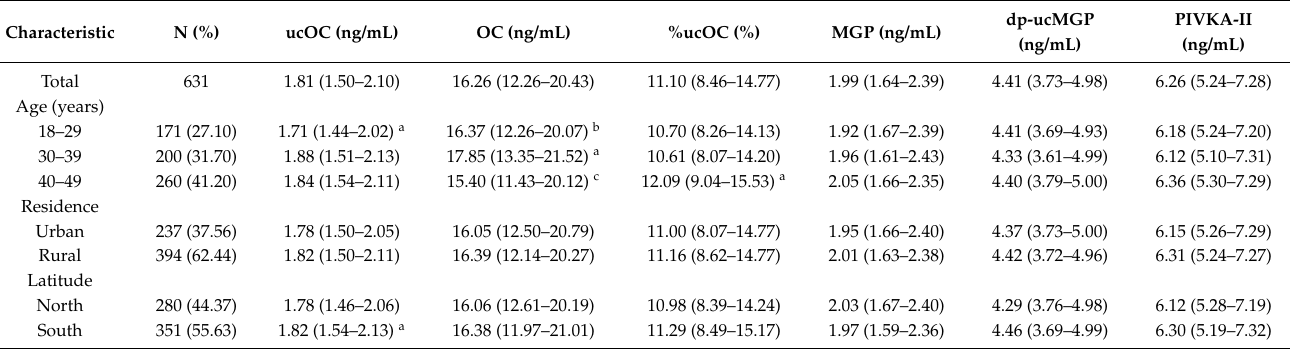
Table 4. Concentration of vitamin K-related indicators in